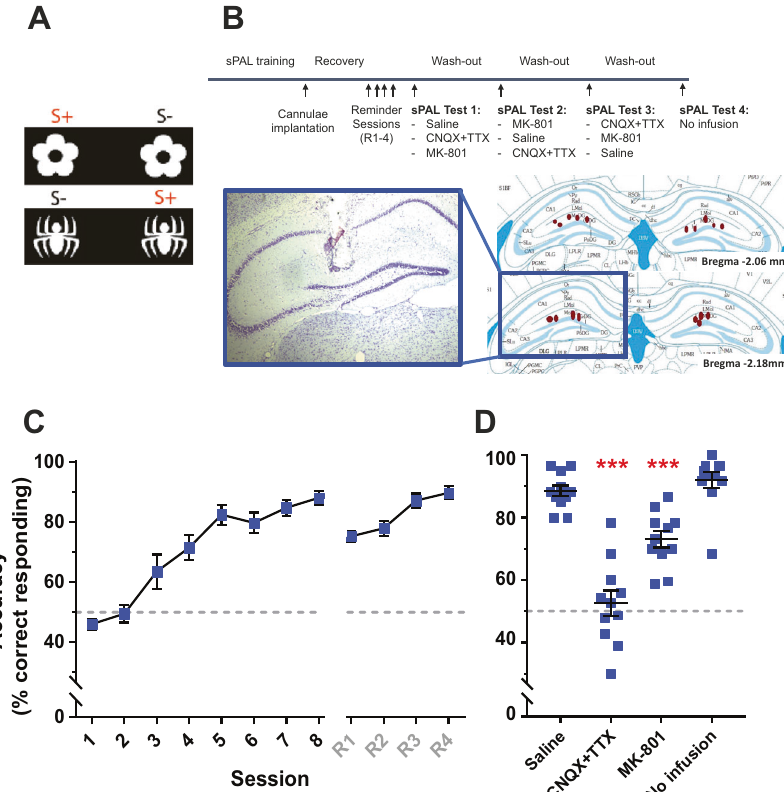
Fig. 3 Validating hippocampal dependency for performance in the two-object sPAL touchscreen task. A sPAL visual stimuli (S + rewarded, S − unrewarded). B Experimental sequence of hippocampal infusion study. Images show representative histological veri fi cation of cannula placement (left) and indicative sites of cannula tip placements across the group of mice tested (right). C Adult (12 W) male mice have trained on two-object sPAL over 8 testing sessions and showed rapid acquisition to 80% response accuracy. Animals subsequently underwent surgery to have bilateral infusion cannulae implanted into the dorsal hippocampus. Mice were given four reminder sessions (R1 – R4) to reestablish pre- surgery performance levels. Data represent mean ± SEM, n = 11 male mice. Gray dotted line indicates performance at the chance (50% accuracy). D sPAL performance following dorsal hippocampal infusions with either (i) saline alone, (ii) MK-801 (NMDA receptor antagonist), or (iii) CNQX (AMPA/kainate receptor antagonist) + TTX (selective sodium channel blocker) or no infusion. Signi fi cant main effect of treatment, repeated measures ANOVA ( F (3, 30) = 48.51, P < 0.001). Post hoc Dunnett ’ s multiple comparisons test showed that compared to saline treatment, both CNQX (3 mM) + TTX (20 µM) ( P < 0.001) or MK-801 (10 mM) ( P < 0.001) signi fi cantly decreased performance